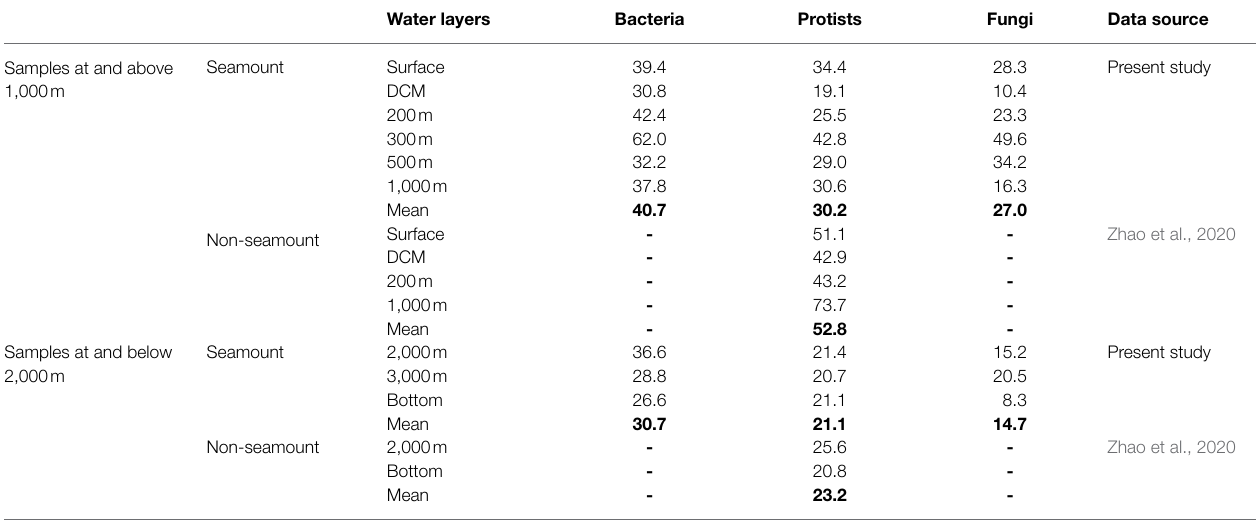
TABLE 2 | Proportions (%) of OTUs shared among samples within each water layer